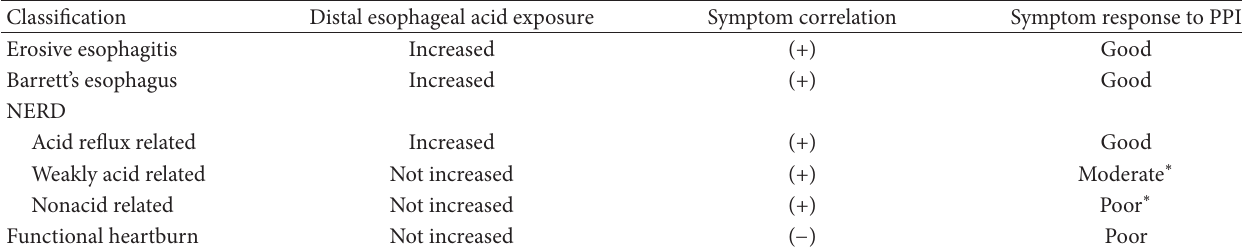
Table 1: Classification of patients with reflux symptoms.